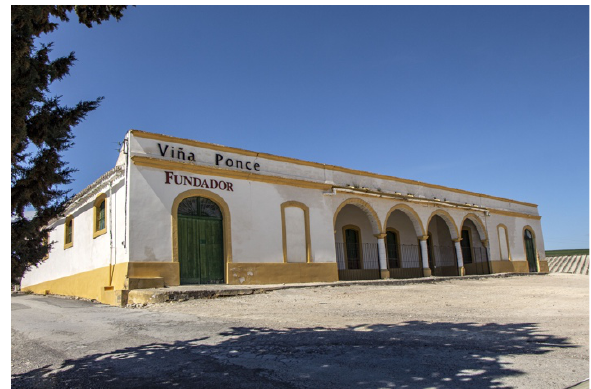
Figure 9. Casa de viña. Viña Ponce, Jerez de la Frontera. (Agustín and José García Lázaro).